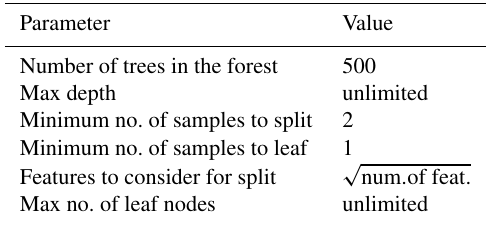
Table 3. Hyperparameters for the